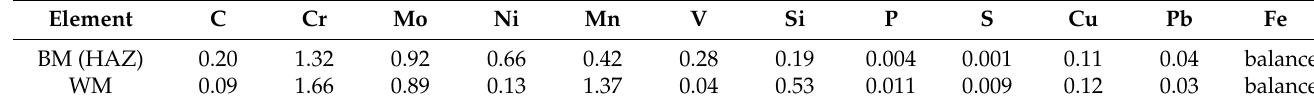
Figure 1. Gas turbine rotor and toughness test sampling: ( a ) the actual rotor after 14 years of service and its three parts; ( b ) the materials cut from the turbine part and the compressor part; ( c , d ) the sampling process and the dimensions (in mm) of the standard Charpy V-notch impact test specimens. Table 1. Chemical composition of BMs and WMs in the turbine part and the compressor part (wt.%).